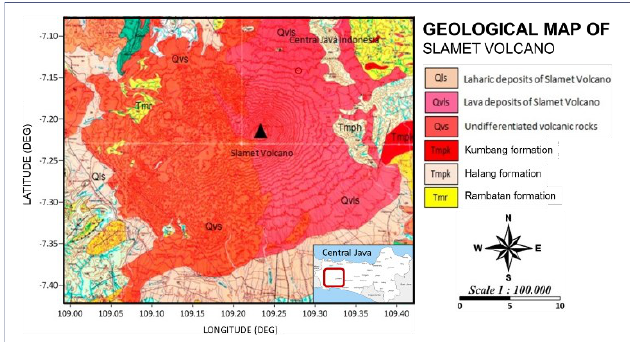
Fig. 2. Geological map of Slamet Volcano and its surrounding areas